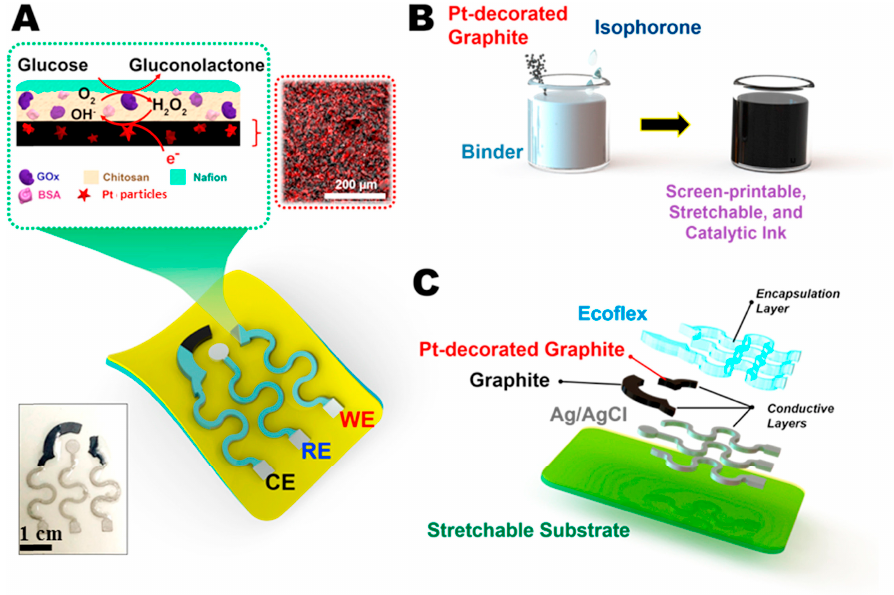
Figure 12. ( A ) Diagram showing the design of the stretchable sensor, the immobilization of enzymes on the printed catalytic layer, and the reaction during detection. A real image of a screen-printed sensor is displayed in the inset. ( B ) Preparing screen-printable, stretchable, and catalytic ink. ( C ) Screen-printing process illustrating the component layers [133]. Reprinted with permission. Copyright (2017) Elsevier.